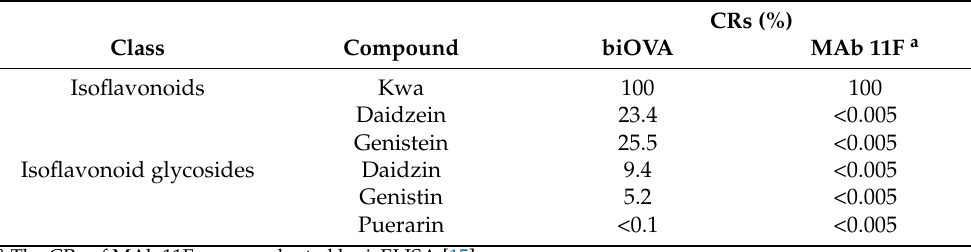
Table 1. The CRs of biOVA against major isoflavones, evaluated by